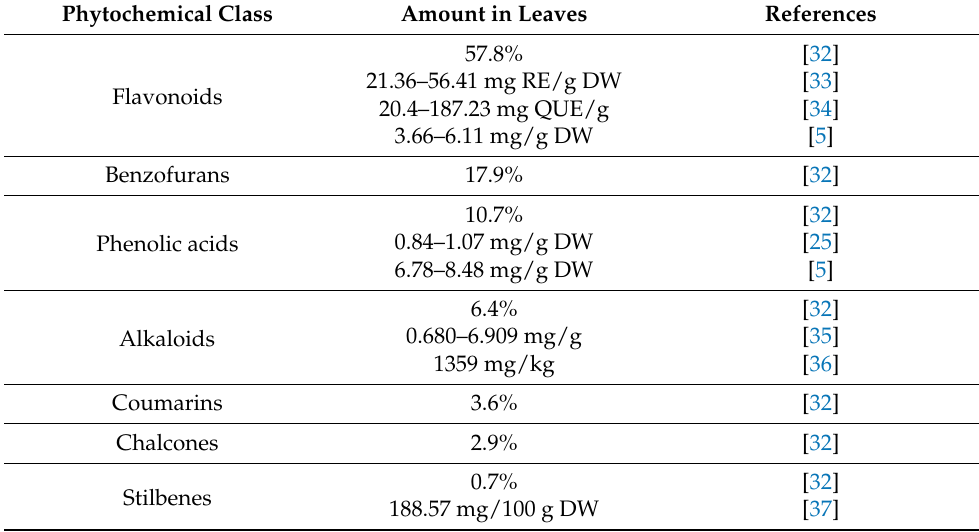
Table 3. Major phytochemical classes in M. alba